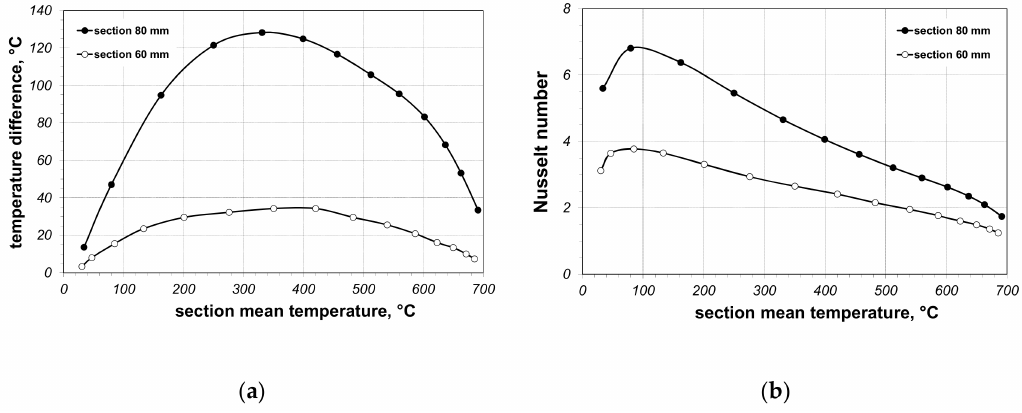
Figure 5. Values for the 60 and 80 mm sections: ( a ) temperature di ff erence ∆ t and ( b ) Nusselt number